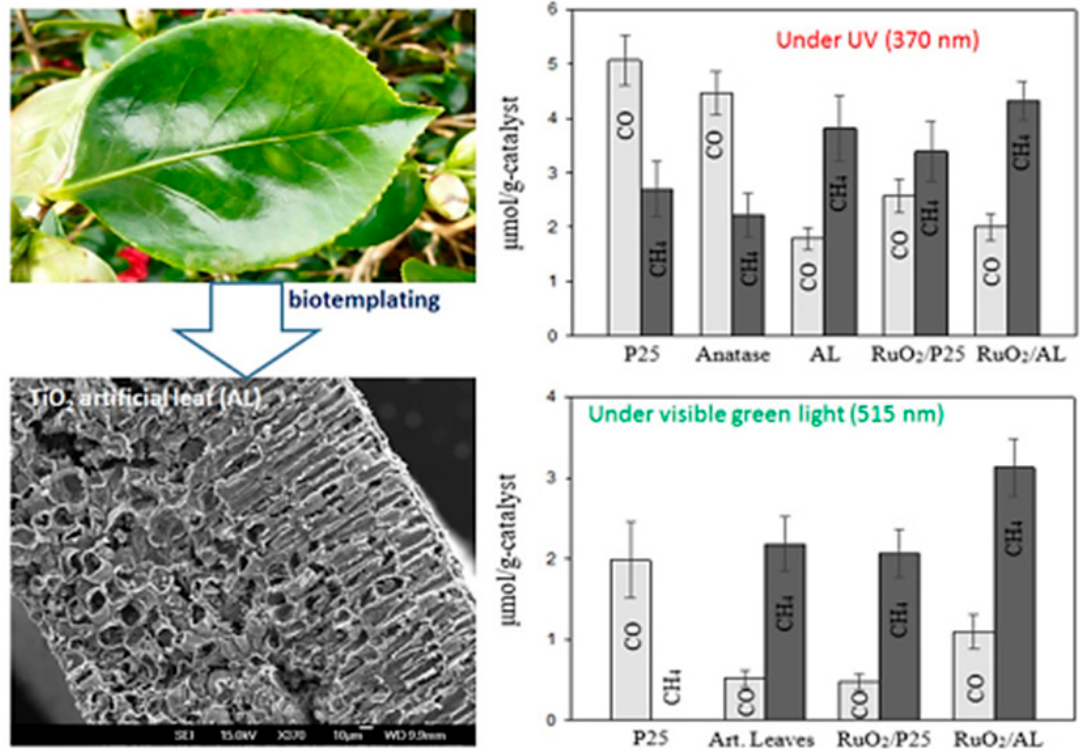
Figure 12. Image of camellia leaf, SEM image of artificial leaf displaying a porous structure, and the production rate of CO and CH 4 via the photocatalytic conversion of CO 2 and water vapors (taken with permission from [74]).